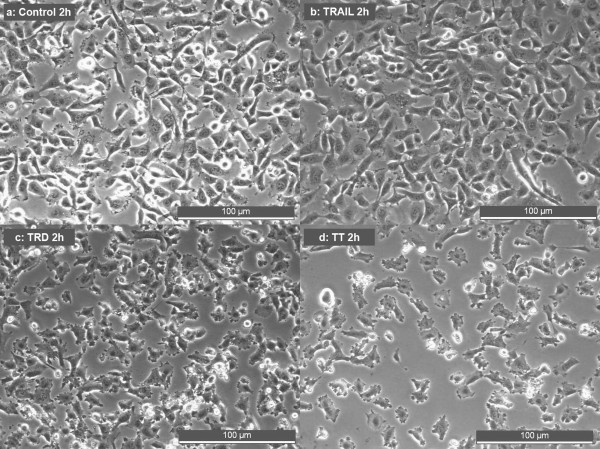
Phase contrast microscopic photographs showing morphologic changes induced by TRD, TRAIL and combination of both agents after 2 h: Cells were incubated with Povidon 5% + H2O (control) (a), 50 ng/ml TRAIL (b), 250 μmol/l TRD (c) and a combination of TRD/TRAIL (d).